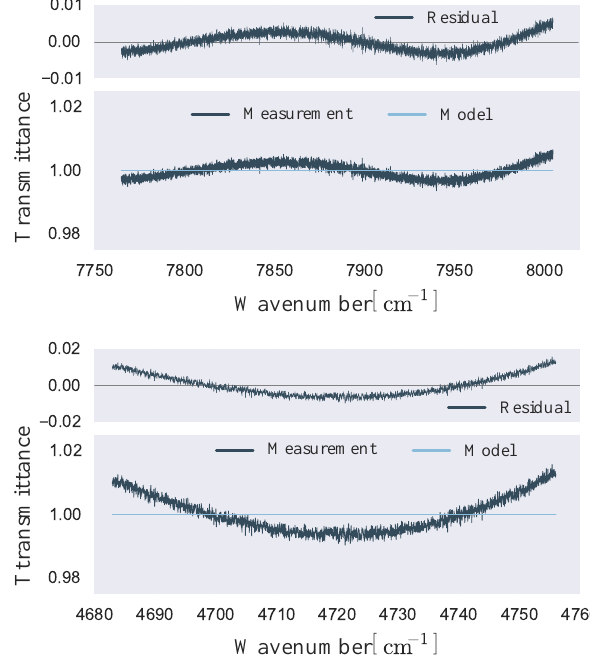
Figure 3. Same as Fig. 2 but for Karlsruhe cavity spectra. Both residuals follow the same shape as seen for atmospheric measure-